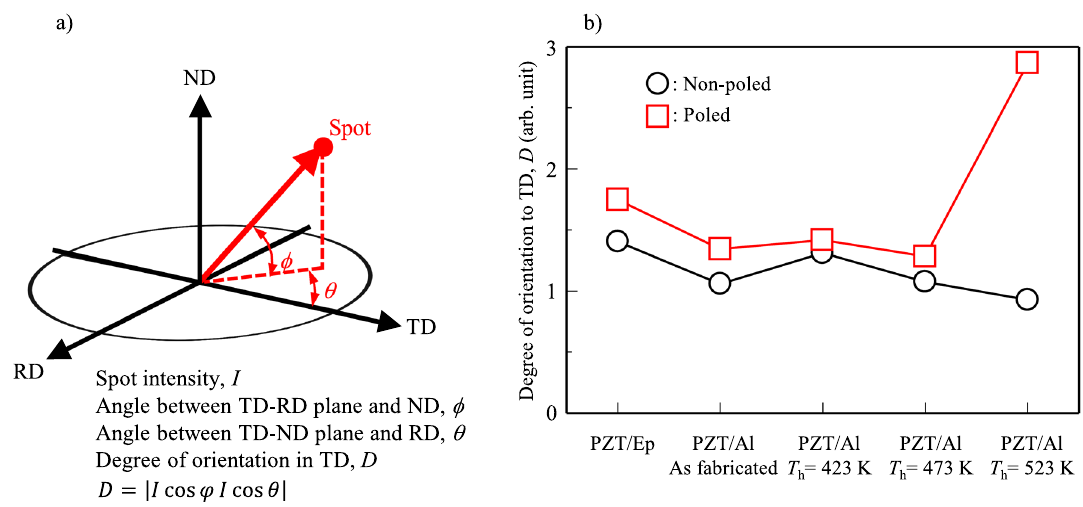
Fig. 4 Evaluation of polarization using the degree of orientation with respect to TD. a Calculation of the degree of orientation and b degree of orientation in each specimen. The difference in the degrees of orientation of PZT/Ep and PZT/Al may be attributed to crystalline orientation along the ND due to residual stress.